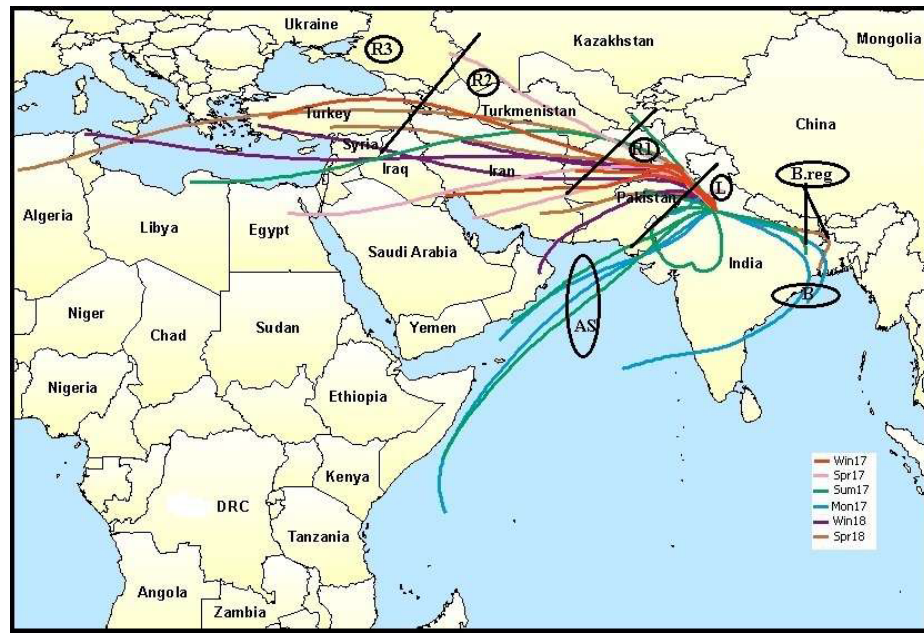
Figure 1. HYSPLIT grouping of cluster mean trajectories based on directions and distances of source regions. Cluster mean trajectories were obtained for all seasons and clubbed as per directions. AS branch originated from the Arabian Sea; BB branch, with sub-branches B and B.reg, originated from Bay of Bengal; and SA branch, with sub-branches L, R1, R2, and R3 from the north-western direction, originated mainly on the southern Asian landmass. The map layer used is from “World Countries (Generalized)”, by Esri, Garmin International (2010, https://www.arcgis.com/home/item.html?id=170b5e6529064b8d9275168687880359, last access: 17 May 2020). © Esri, Garmin. All rights reserved. This map is intellectual property of Esri, Garmin, and used under license. Further details may be found at https://www.esri.com